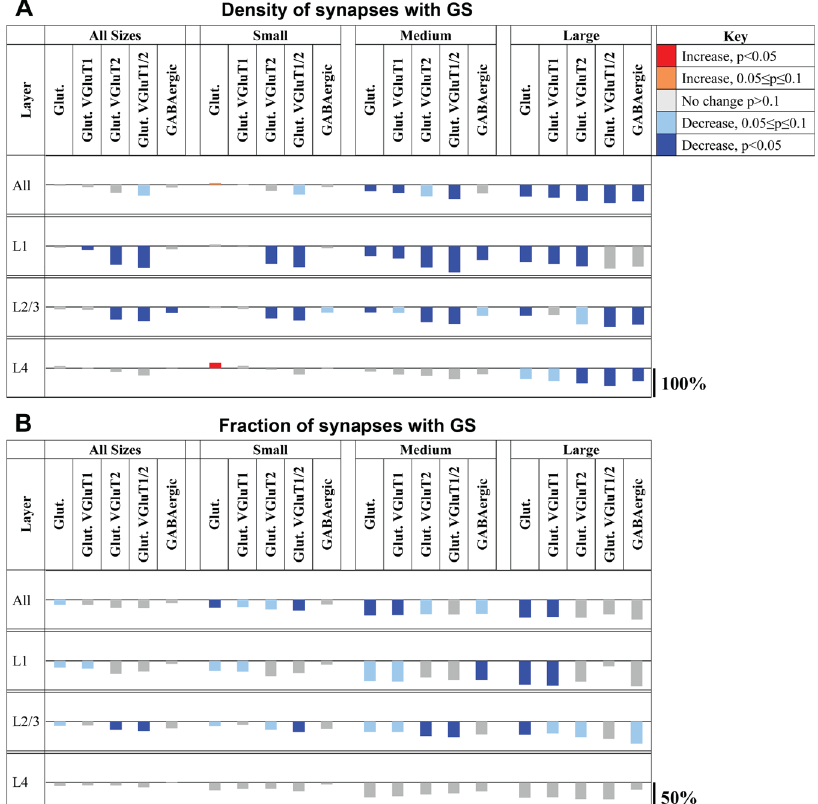
Figure 8. Summary of the astrocytic synapse density differences in the knockout mice. ( A ) Changes are shown as the percentage difference in density between the wild-type and knockout mice. Plots are color-coded to indicate direction of change and statistical significance. The density decreases between the wild-type and knock-out mice for Layers 1–3 and the difference is especially pronounced for medium and large synapses. ( B ) Changes in the fraction of synapses adjacent to astrocytic